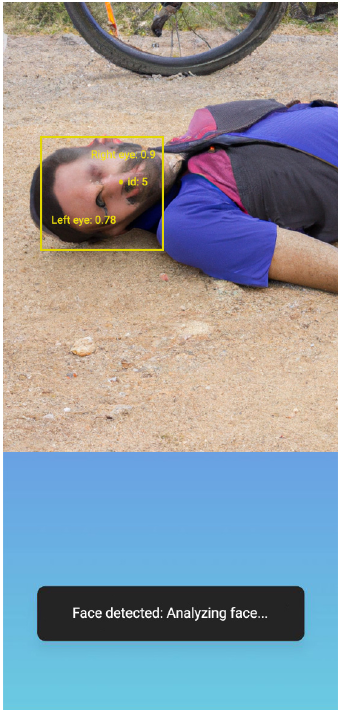
Figure 4. Doctor’s interface for face